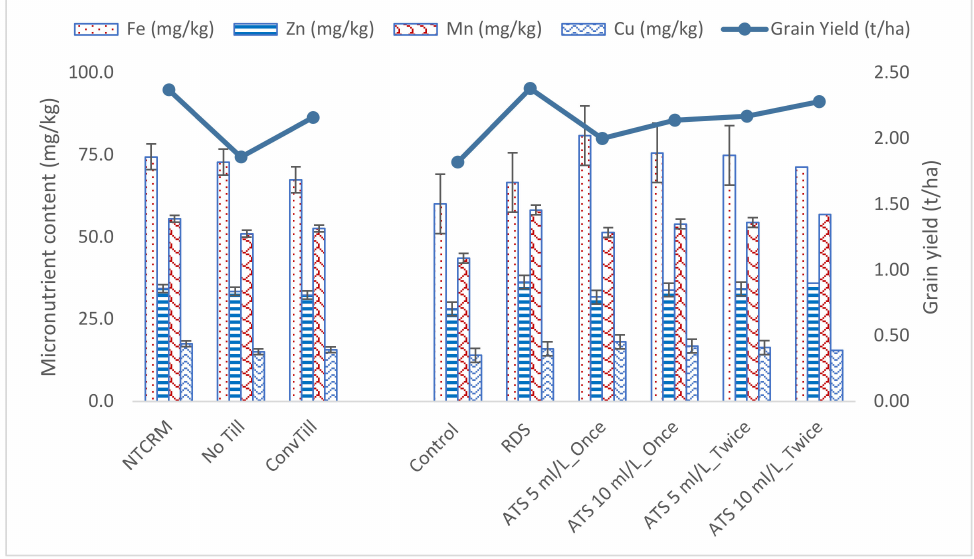
Figure 2. Micronutrient content (mg/kg) in grain and grain yield (t/ha) of pearl millet as influenced by crop establishment methods and sulphur management strategies (mean of two years of